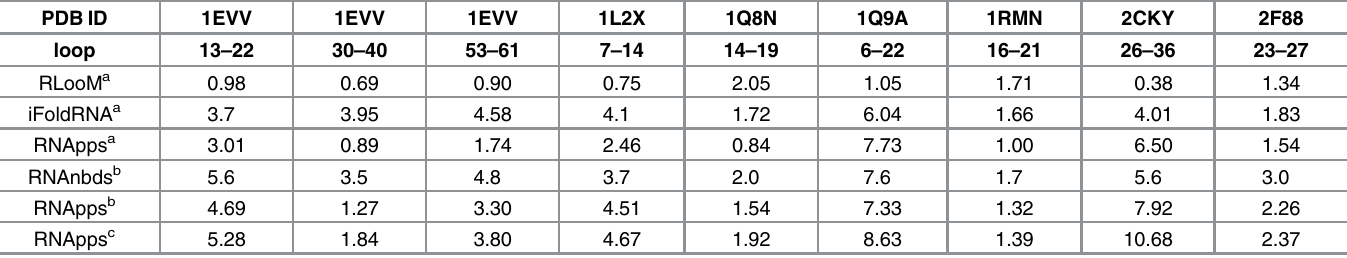
a RMSD of reduced backbone trace after optimal superposition with the experimental RNA loop. b RMSD of heavy atoms after optimal superposition with the experimental loop. c RMSD of heavy atoms after optimal superposition of the anchors. The unit is